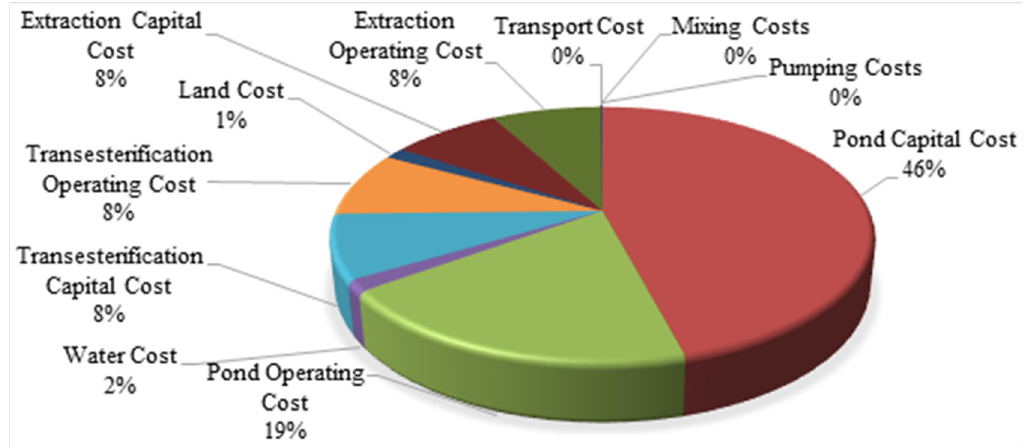
Figure 14. The cost associated with the Oklahoma algae biomass to biodiesel supply chain network.